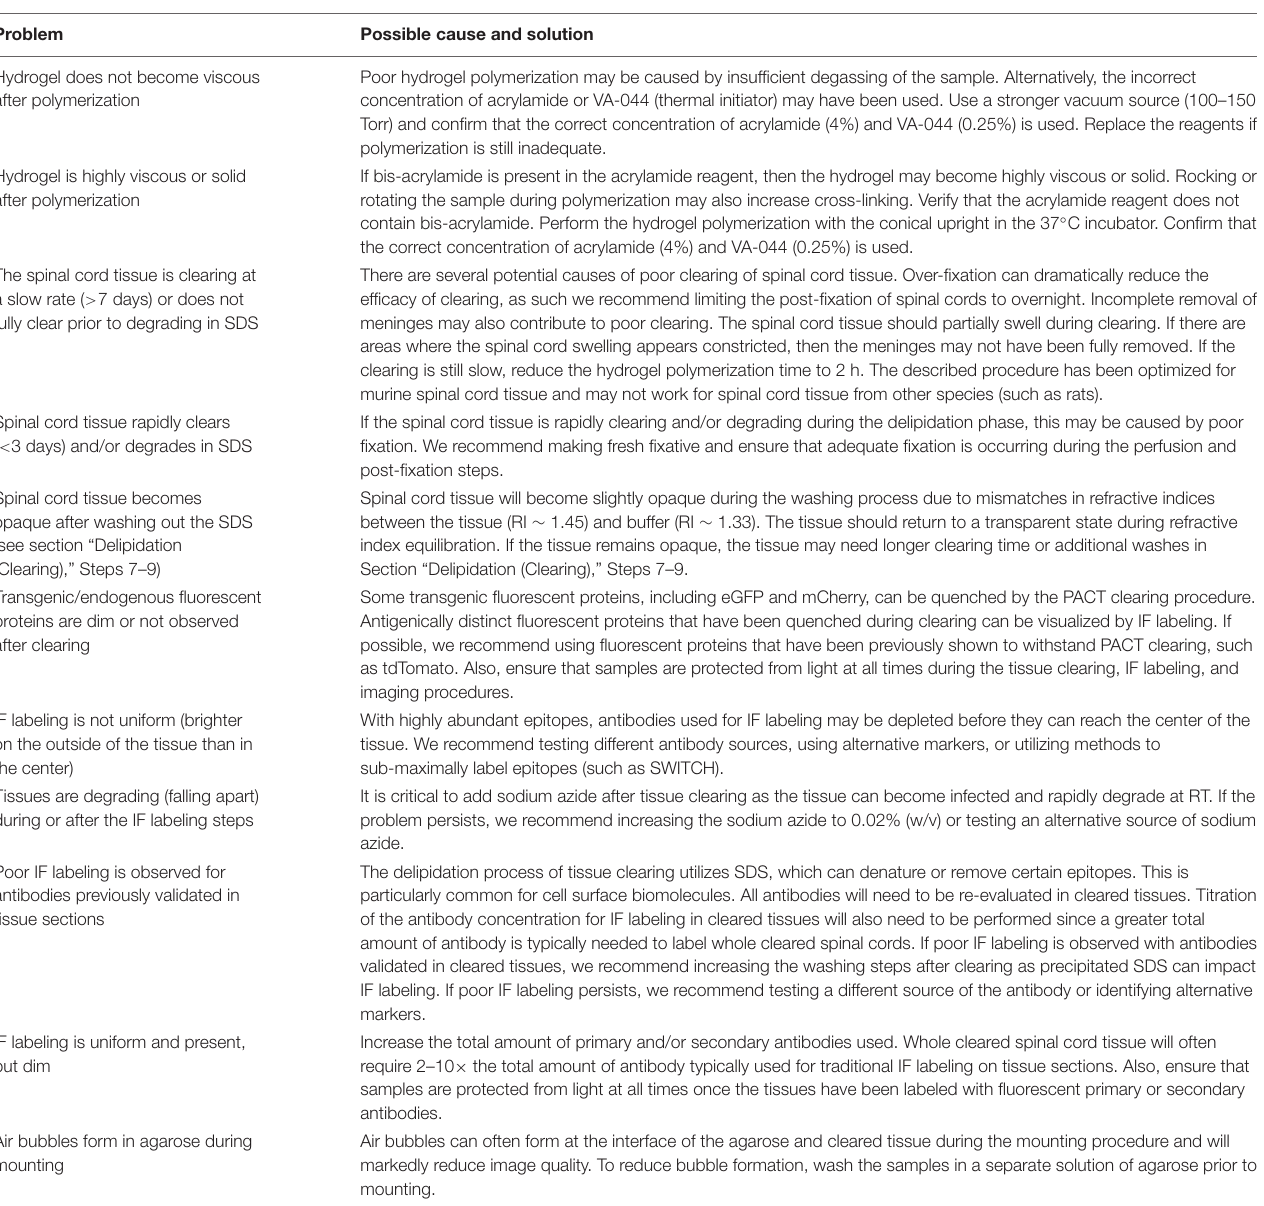
TABLE 1 | Troubleshooting PACT clearing of the whole mouse spinal cord. Problem Possible cause and solution Hydrogel does not become viscous after